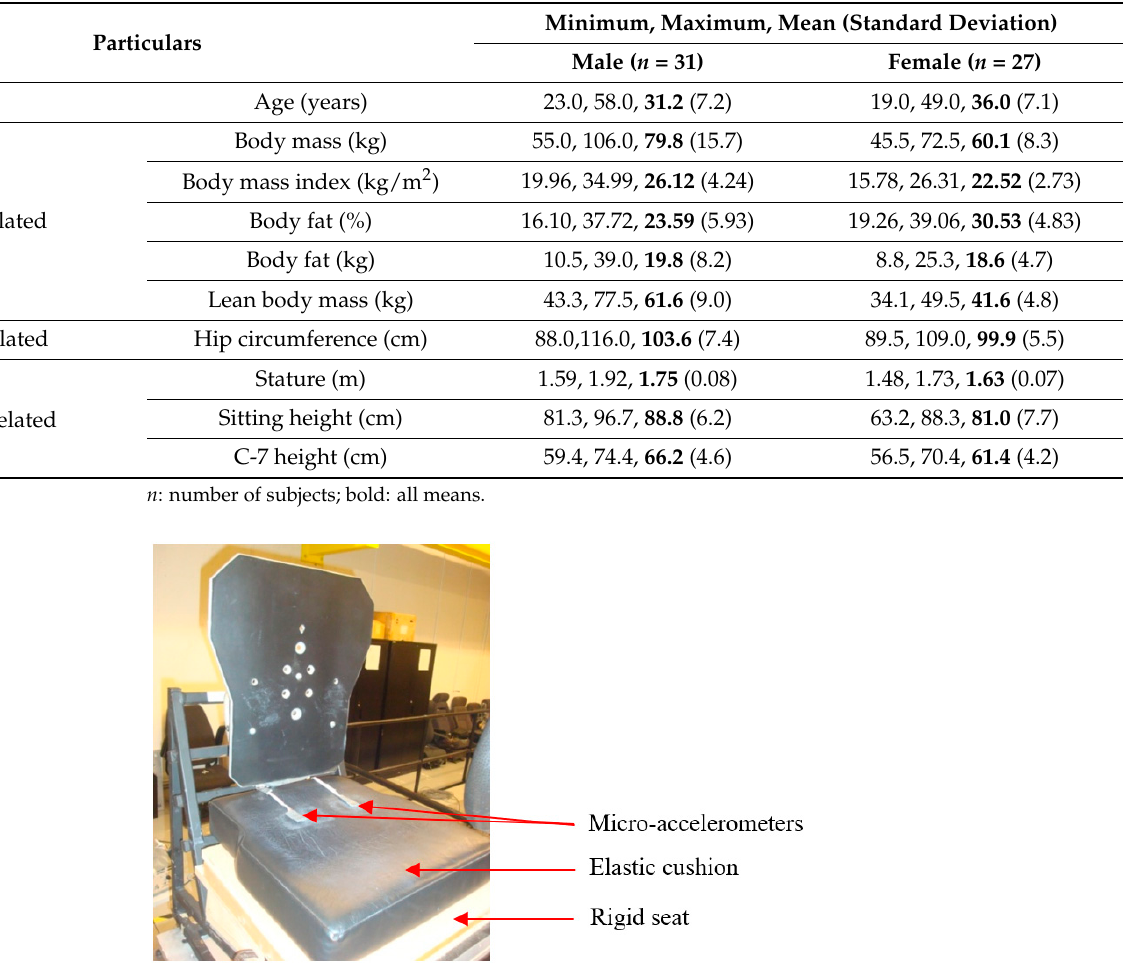
4 Table 1. Mean, standard deviation, minimum, and maximum values of the selected anthropometric parameters of the participants. Particulars